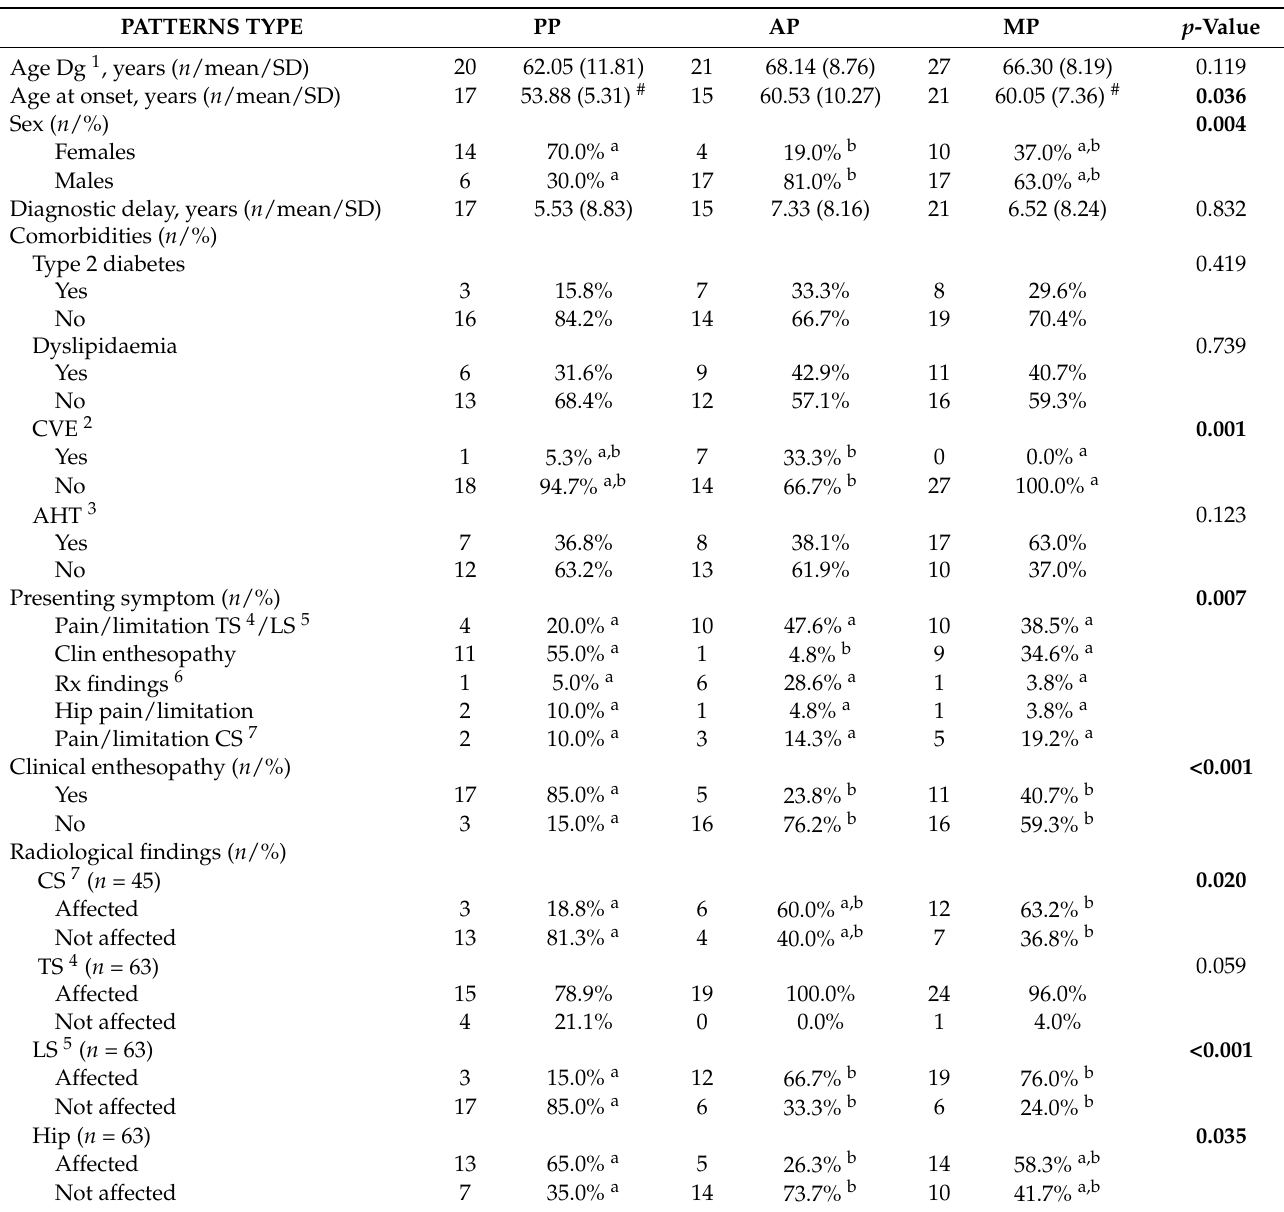
Table 2. Comparison of variables between dish clinicoradiological patterns ( n =